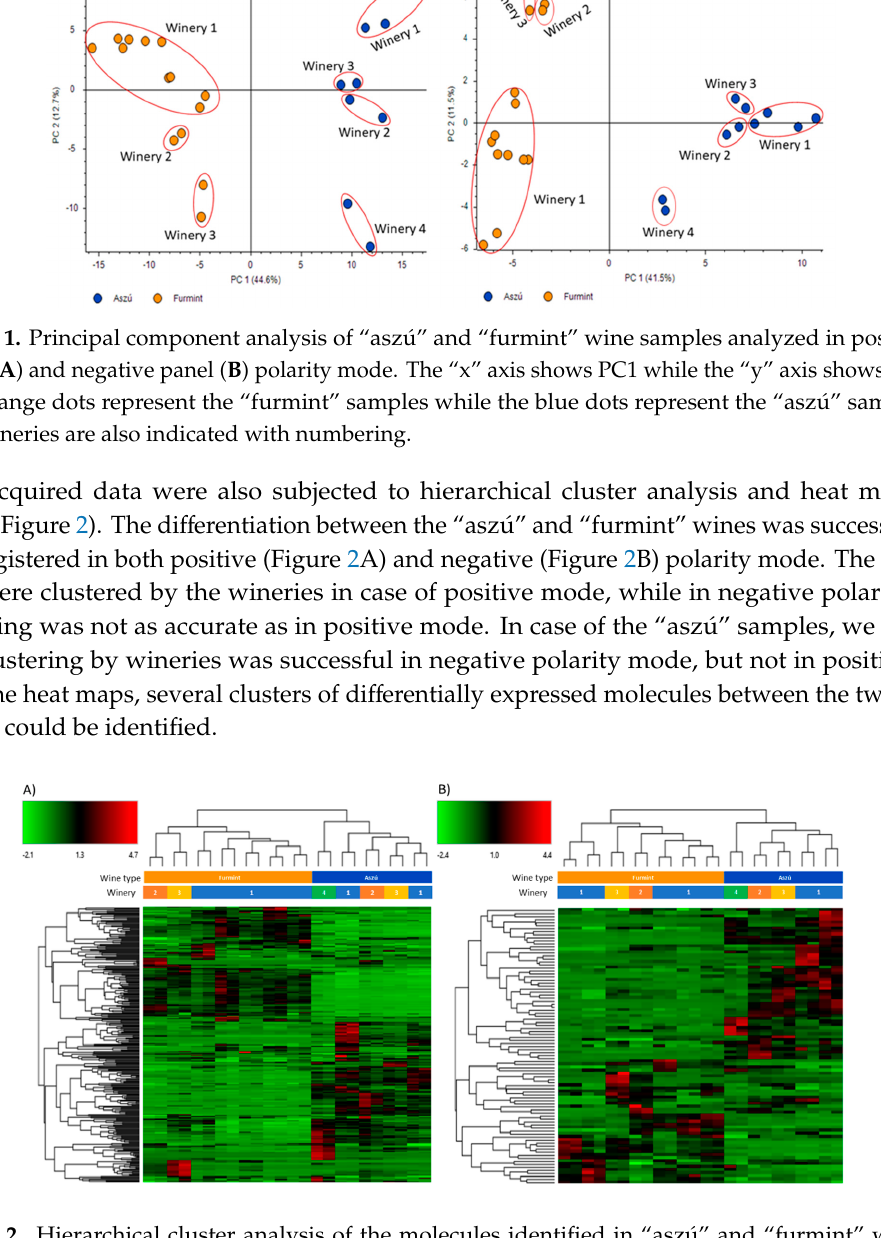
Figure 2. Hierarchical cluster analysis of the molecules identified in “asz ú ” and “furmint” wines registered in positive panel ( A ) and in negative panel ( B ) polarity mode. The green color indicates compounds with lower amount, while the red color shows compounds with higher amount in the comparison of “asz ú ” and “furmint”